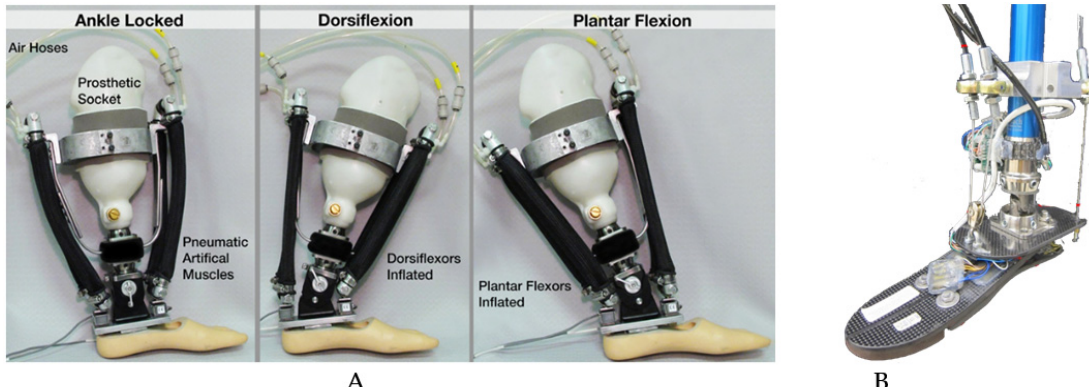
Figure 13. CAS Prosthesis.